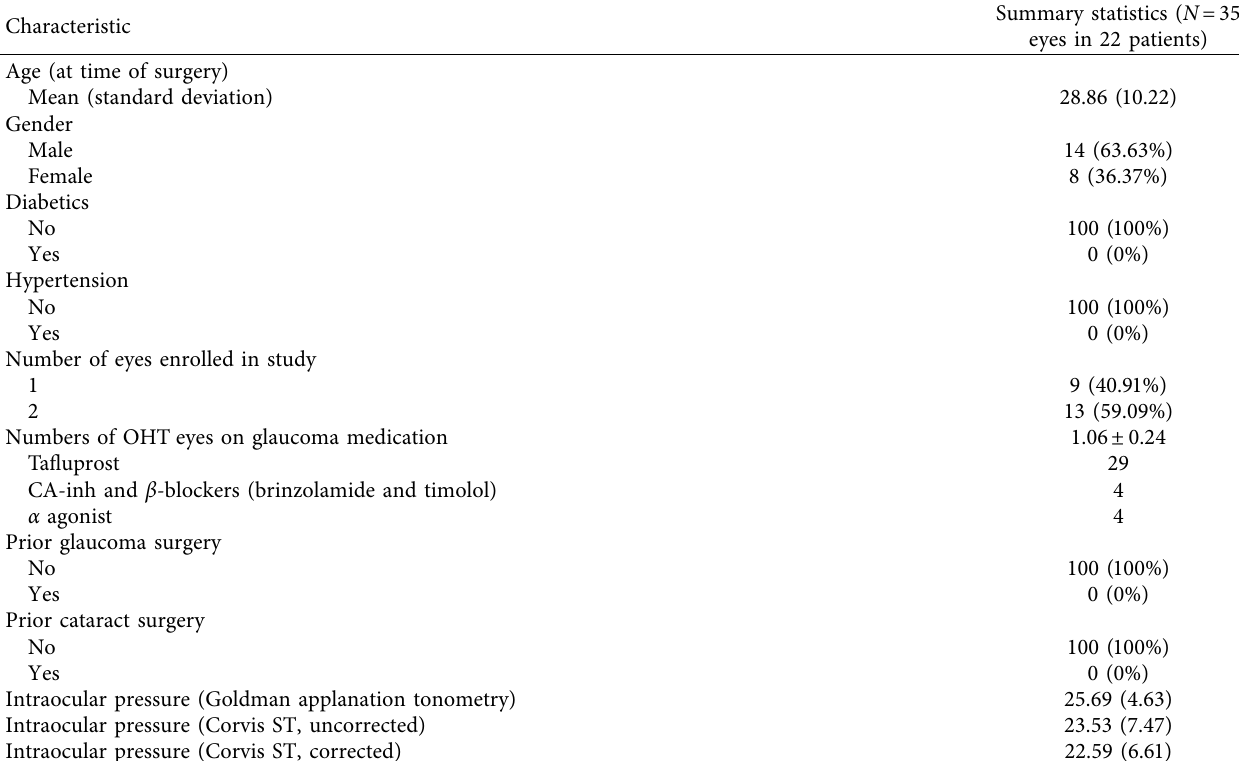
Table 1: Baseline patient and ocular characteristics.